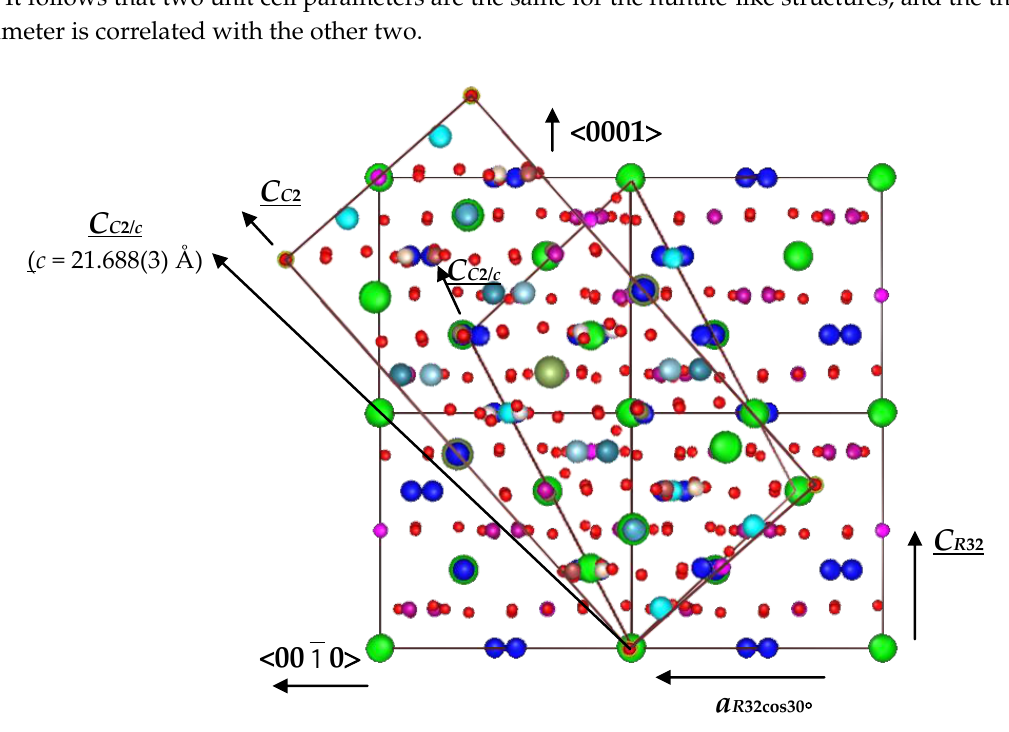
Figure 14. Genetic correlations between the unit cells for the huntite family compounds.